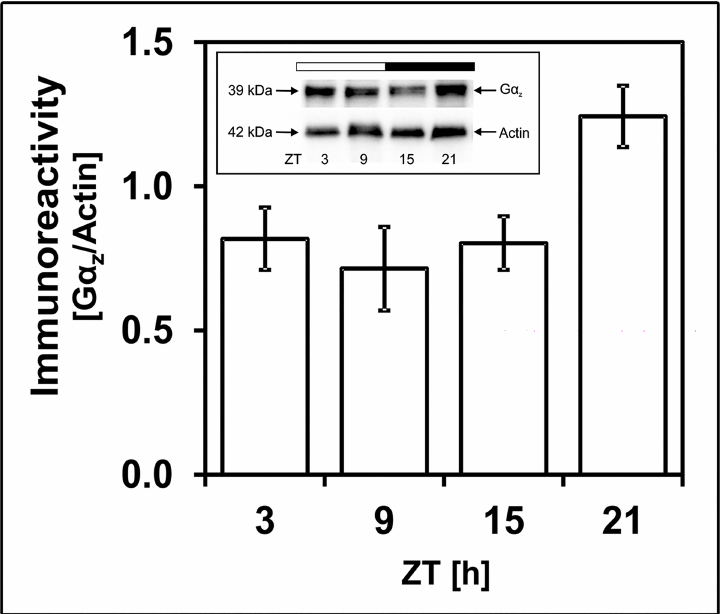
Fig 2. 24-h profiling of G α z immunoreactivity. The figure shows a representativeWestern blot with G α z immunostaining at 39 kDa and β -actin stainingas a loadingcontrol. The diagramdisplaysthe quantification of G α z immunoreactivity in relationto the corresponding β -actin signal.Data were obtainedusing densitometric measurement. Each value represents mean ± SEM (n = 4; each n represents two animals(four retinae)). Note that G α z immunoreactivity tends to exhibitdaily changeswith peak expressionaroundZT21 (p = 0.062 in one- way ANOVA). The solid bar indicatesthe dark